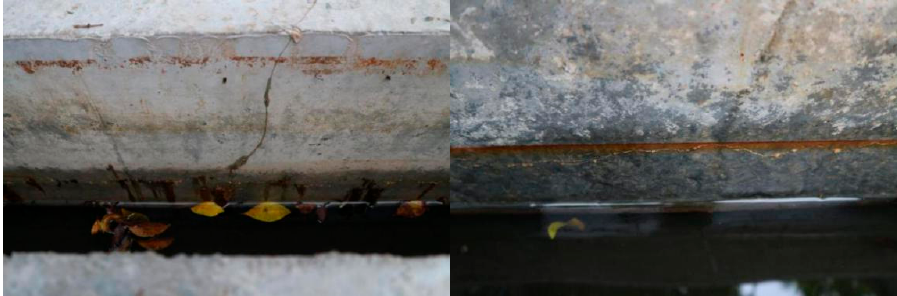
Figure 5. Cracks along the steel bar after the precorrosion.